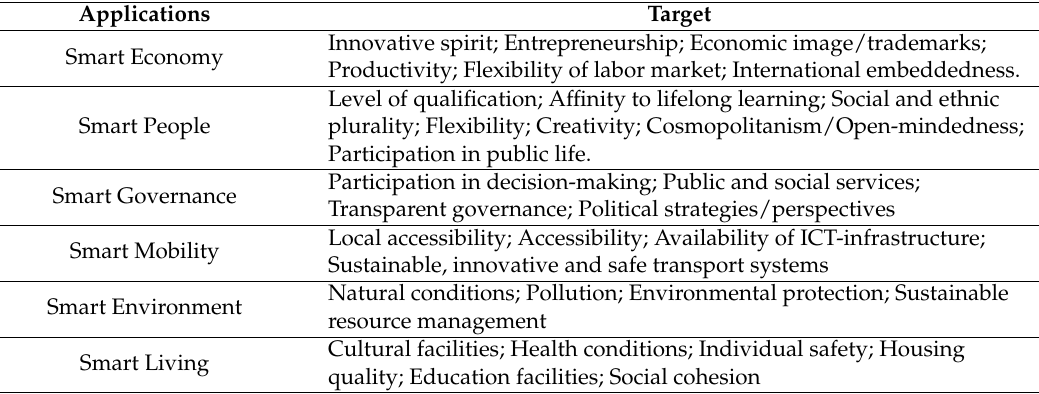
Table 1. Smart City